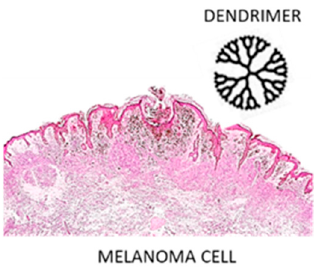
Figure 5. Melanoma cell and dendrimer structure.